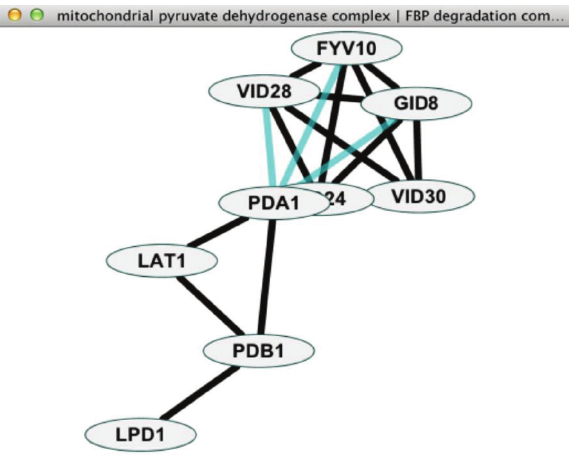
Figure 2. Within-cluster interactions. Figure 3. Between-cluster interactions (in